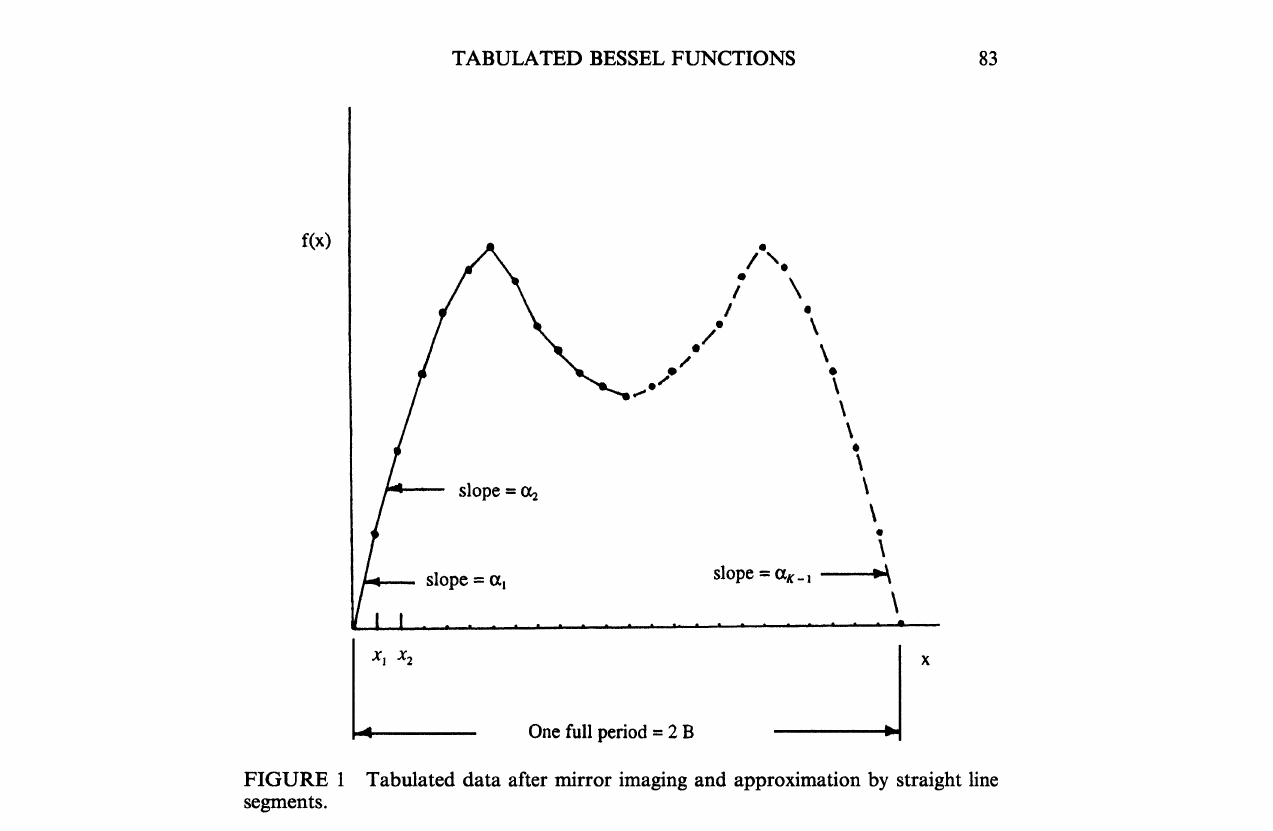
FIGURE Tabulated data after mirror imaging and approximation by straight line